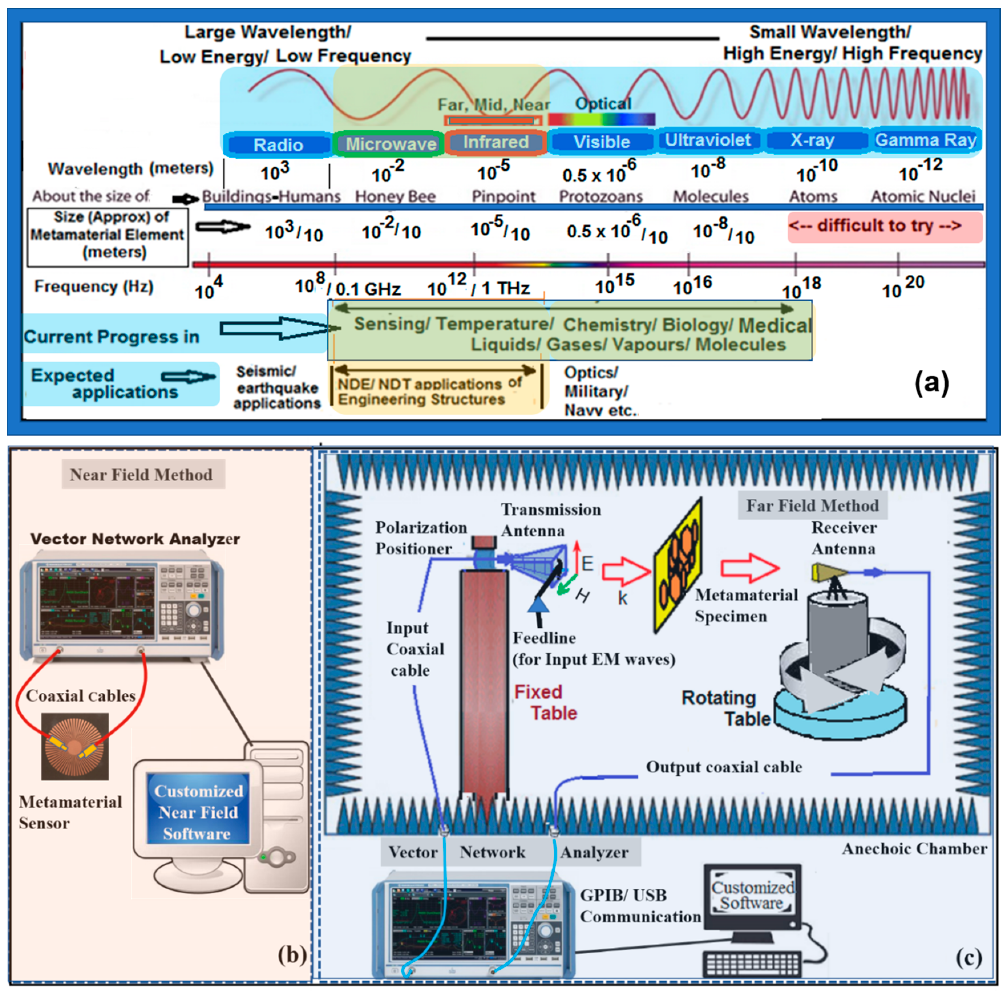
Figure 1. Electromagnetic field ( a ) spectrum, ( b ) input–output of metamaterial in far field, and ( c ) near field.